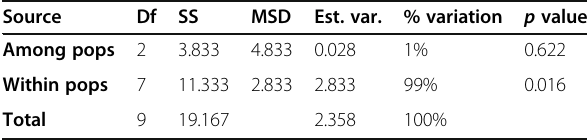
Table 8 Analysis of molecular variance (AMOVA); degrees of freedom (df), mean sum of squares (ss), mean of square deviation (MSD), percentage variation (%), and p values Source Df SS MSD Est. var. % variation p value Among pops